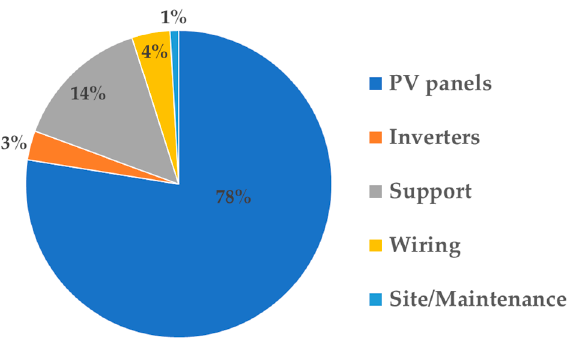
Figure 6. Distribution of carbon impact of the PVCS without considering the power grid.